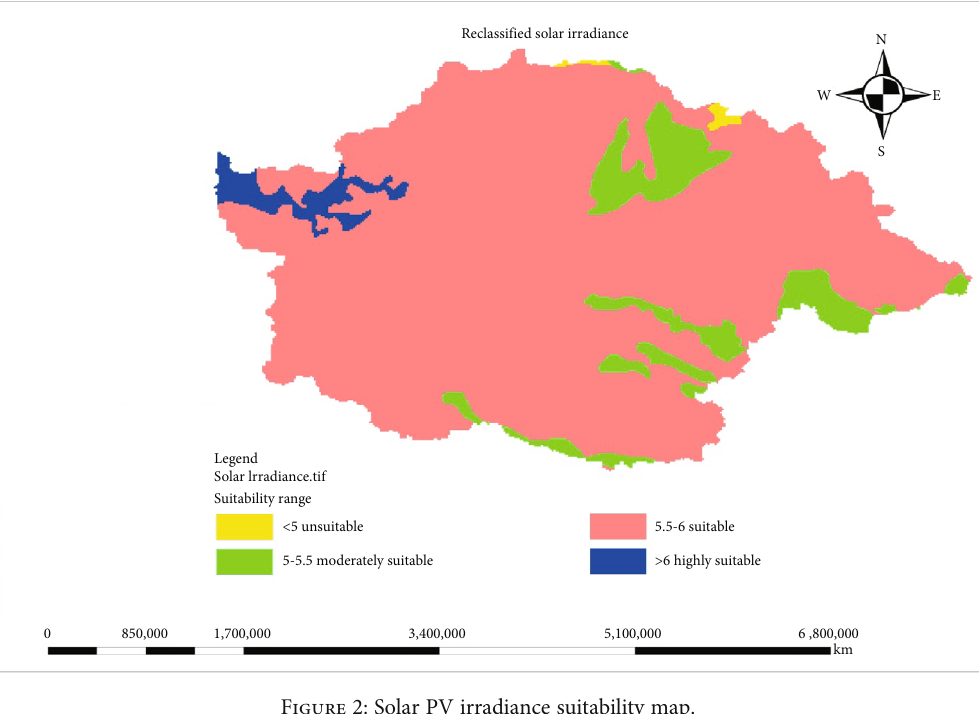
Figure 2: Solar PV irradiance suitability map.